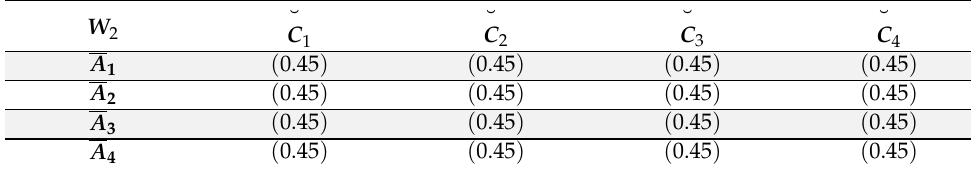
Table 11. Decision matrix in which find the value of W 2 .